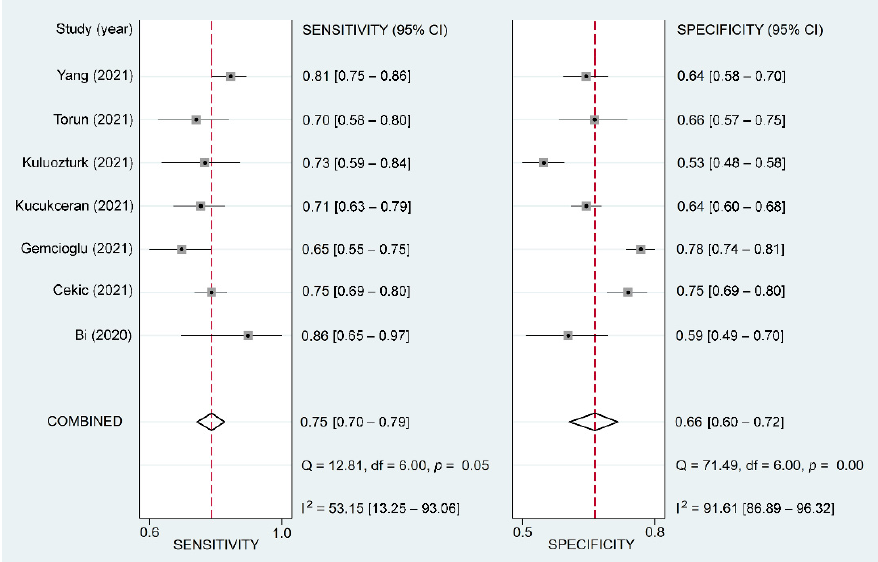
Figure 6. Forest plots comparing the sensitivity and specificity of using fibrinogen-to-albumin ratio for predicting poor prognosis in patients with COVID-19 among the included studies [12,25,32,34,35,37,38].